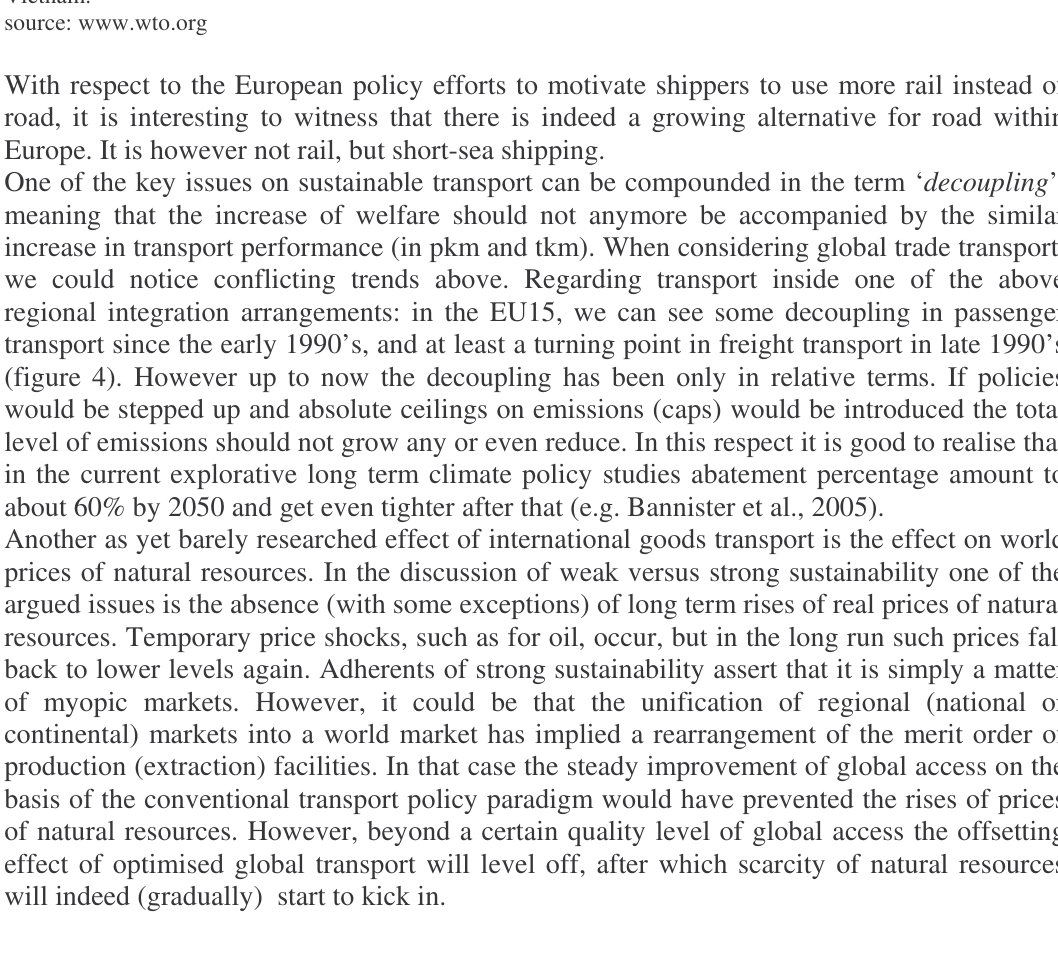
Table 1. Merchandise internal trade of three regional integration arrangements in 2003 Intra-exports (per cent Regional of total exports) integration